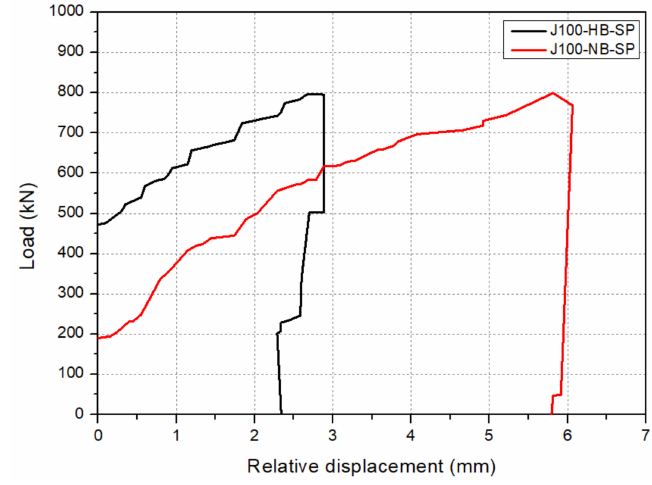
Figure 6. Load–relative displacement curves with respect to the presence of hooked rebars.